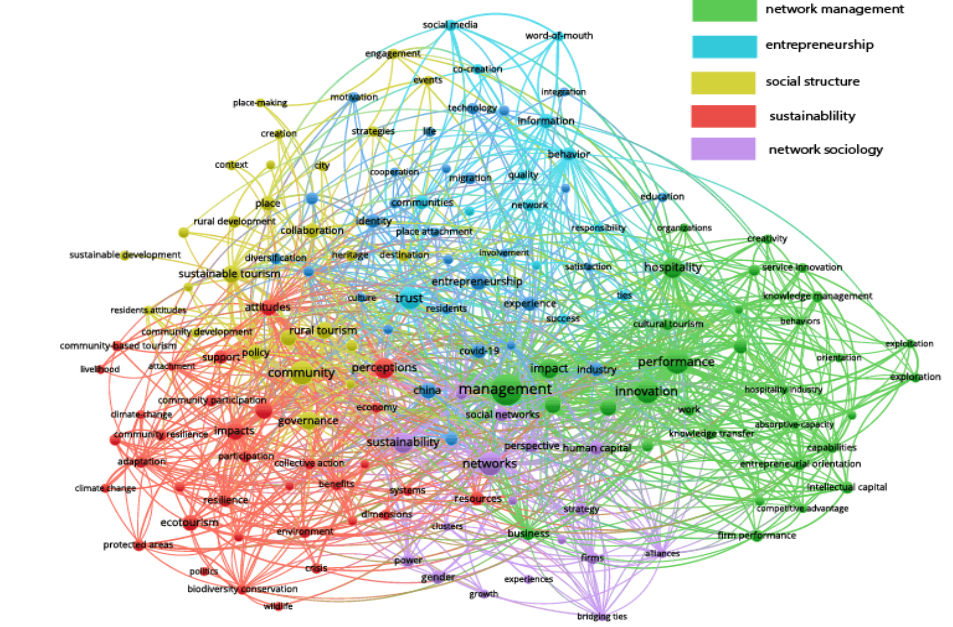
Figure 1. The most important cluster of research on social capital and tourism. One of the largest clusters considers social capital as an important factor contributing to the formation of network of tourism service providers and performance enhancement of tourism sector in each country or region. Another cluster, indicated by the blue color, analyses social capital from point of view of the formation and strengthening of enterprises. This approach is the nearest to our goal. A relatively small cluster analyses the social structure of networks, indicated by a yellow color. Social capital plays an important role in the sustainable development of tourism, especially in formation of individual, nature-close touristic attraction; this cluster is indicated by a red color. The social capital in tourism is an increasingly important part of sociology. A cluster of research topics focusing on the sociological aspect of network formation, is depicted by a lilac color.